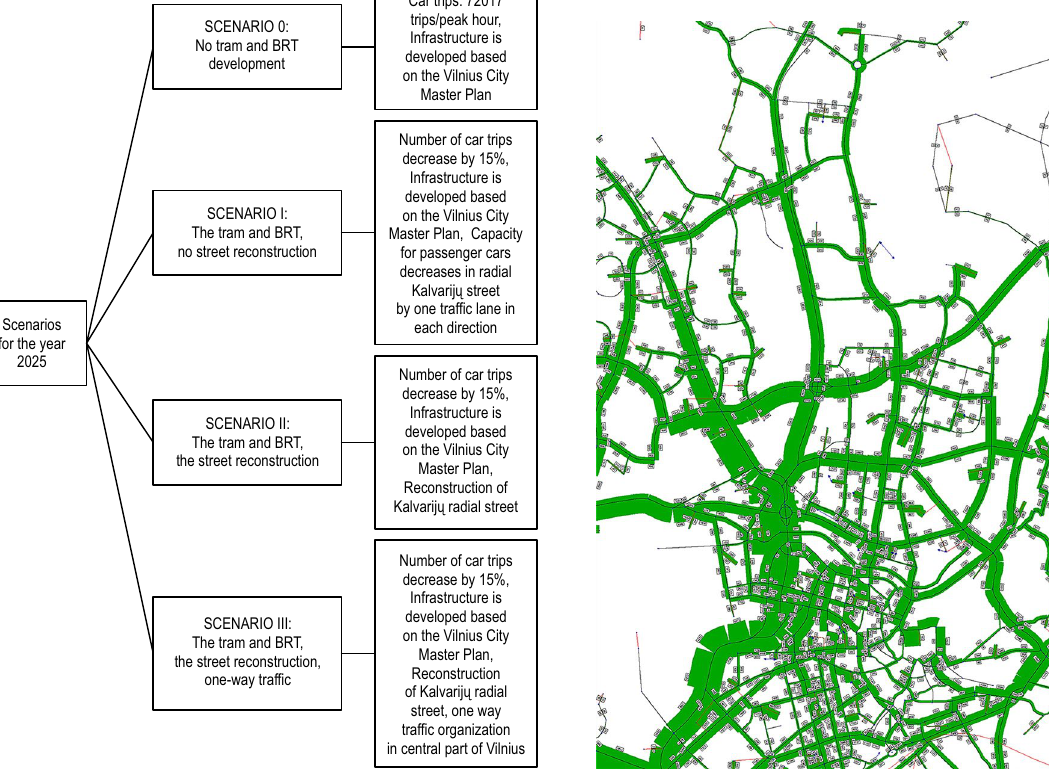
Fig. 7. A fragment of the traffic flow